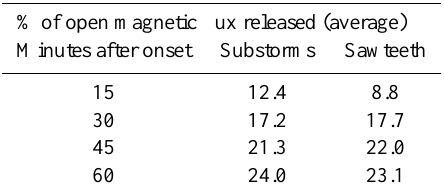
Table 2. The % of open flux released from the tail after onset for substorms and sawteeth.